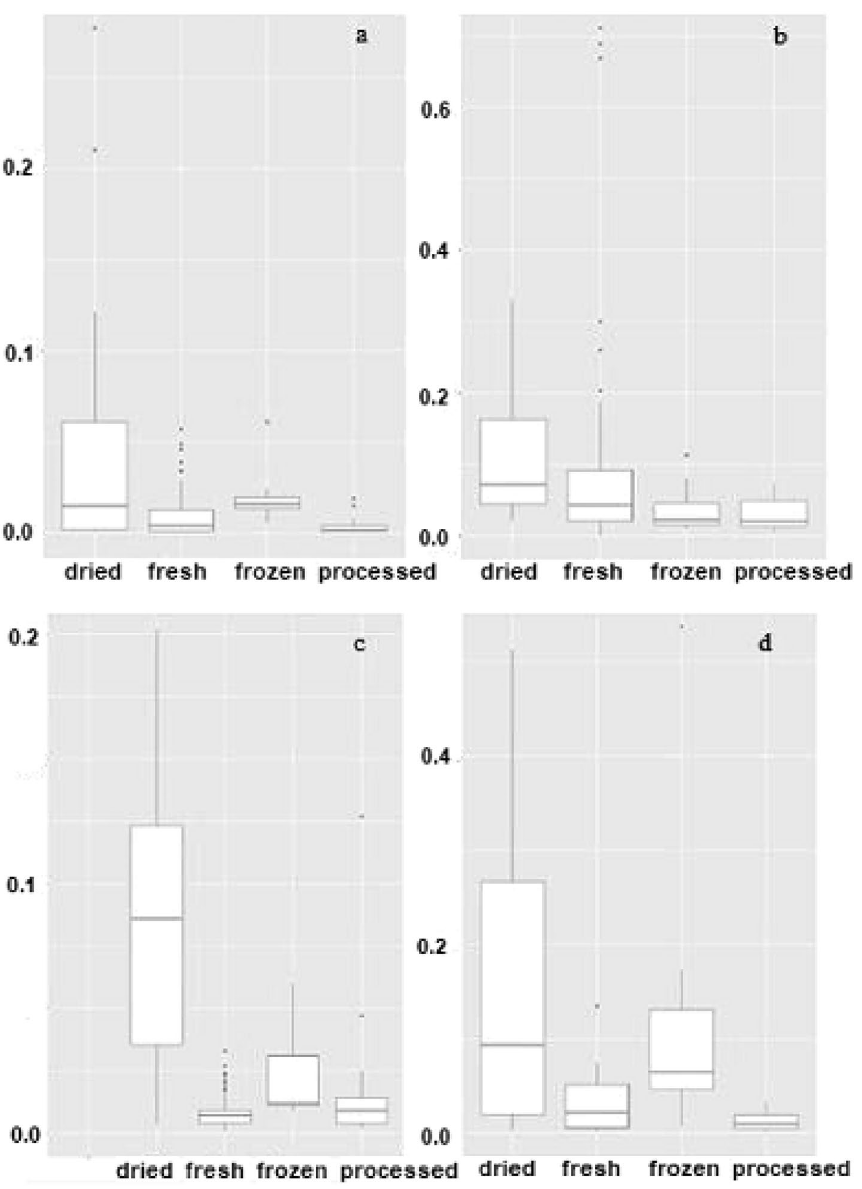
Figure 1. Outlier analysis in case: Cd concentration in: ( a ) fruits, ( b ) vegetables, and Pb concentration in: ( c ) fruits, ( d )